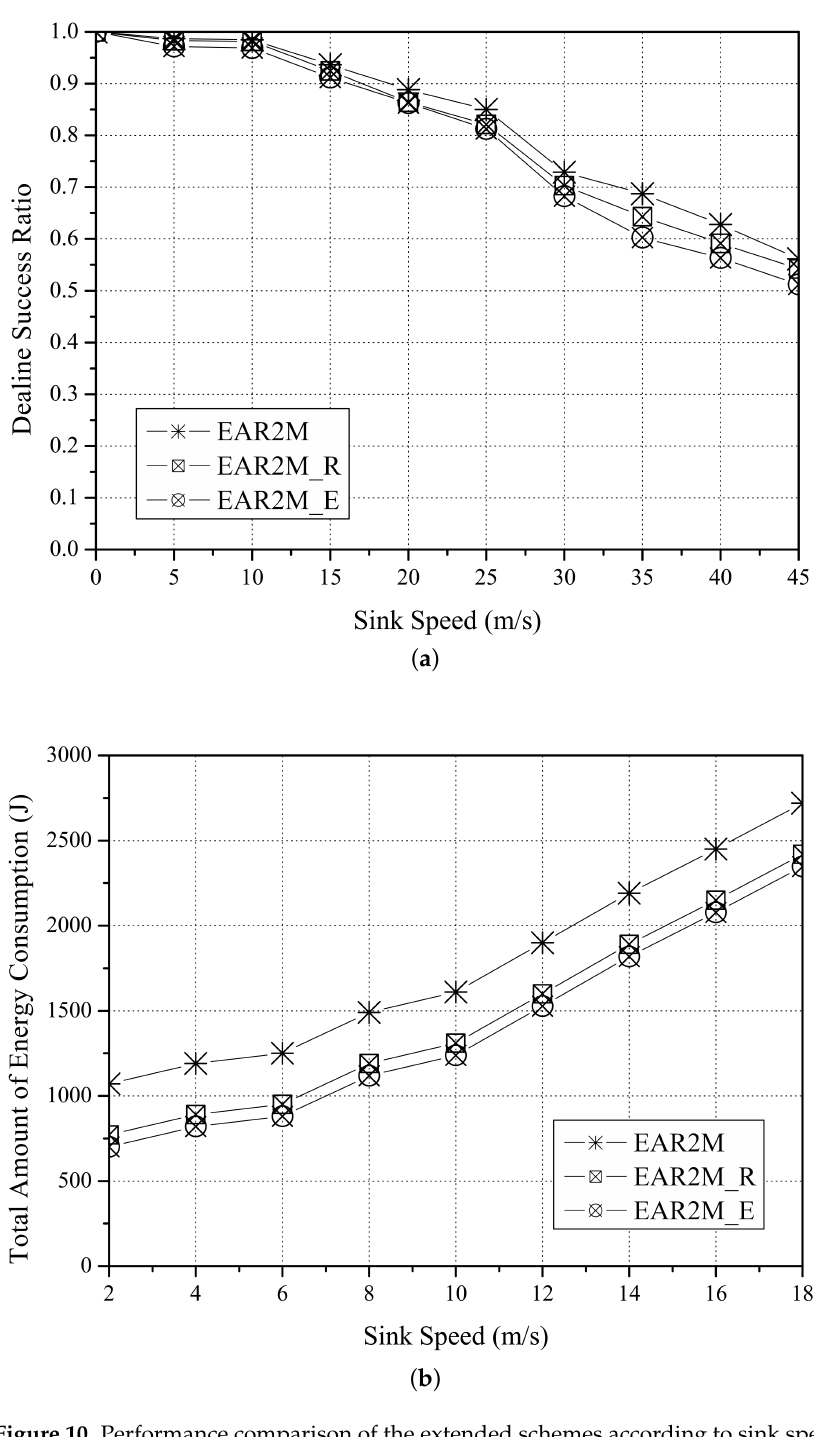
Figure 10. Performance comparison of the extended schemes according to sink speed: ( a ) deadline success ratio and ( b ) energy